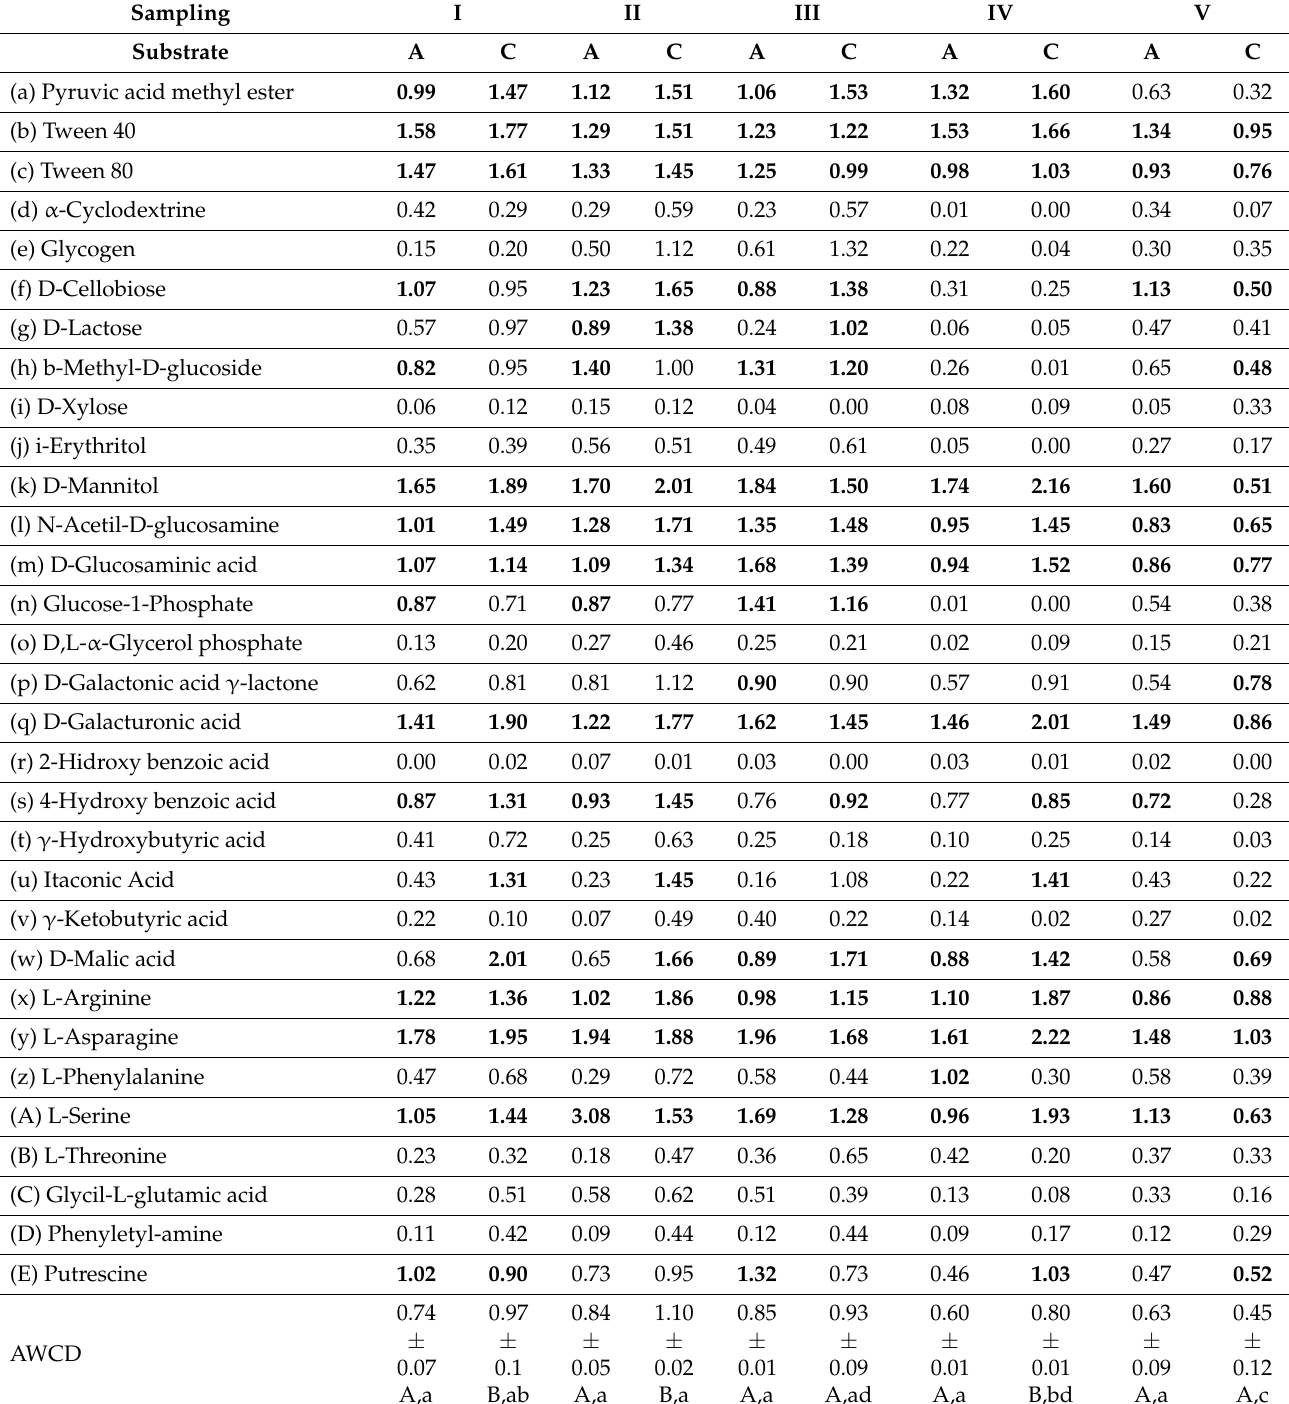
Table 2. Biolog Ecoplate optical densities on 31 substrates and the average well color development (AWCD) recorded for the agricultural (A) and the chestnut (C) soils in the five samplings. Bold numbers indicate values of optical density higher than the corresponding AWCD. In the last row, uppercase letters indicate statistical differences between A and C soils for each sampling, whereas lowercase letters indicate, for each soil, statistical differences among samplings. Different letters correspond to significant differences with p <